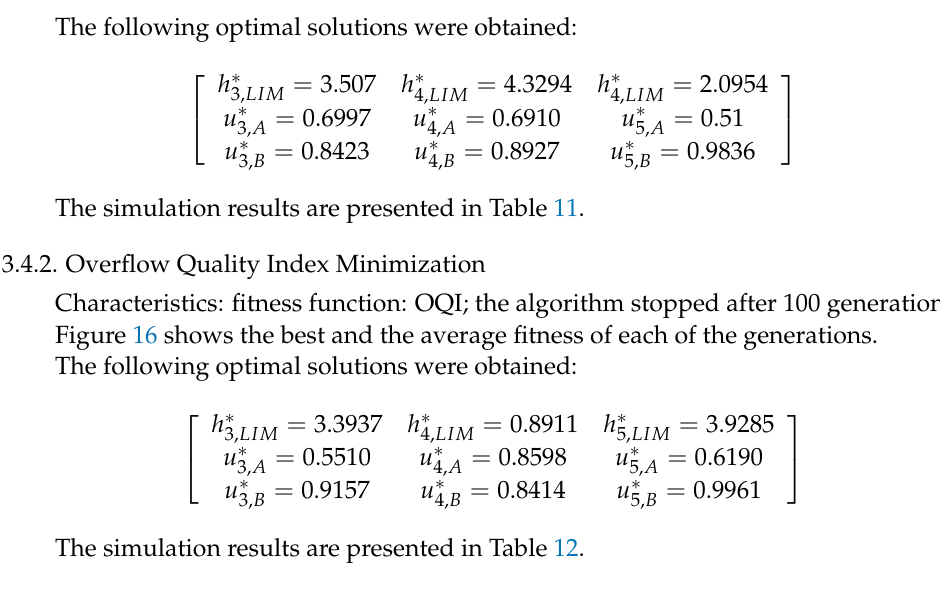
Figure 15. Best and average fitness evolution in control strategy #3 when minimizing V (cid:2925)(cid:2932)(cid:2916) .